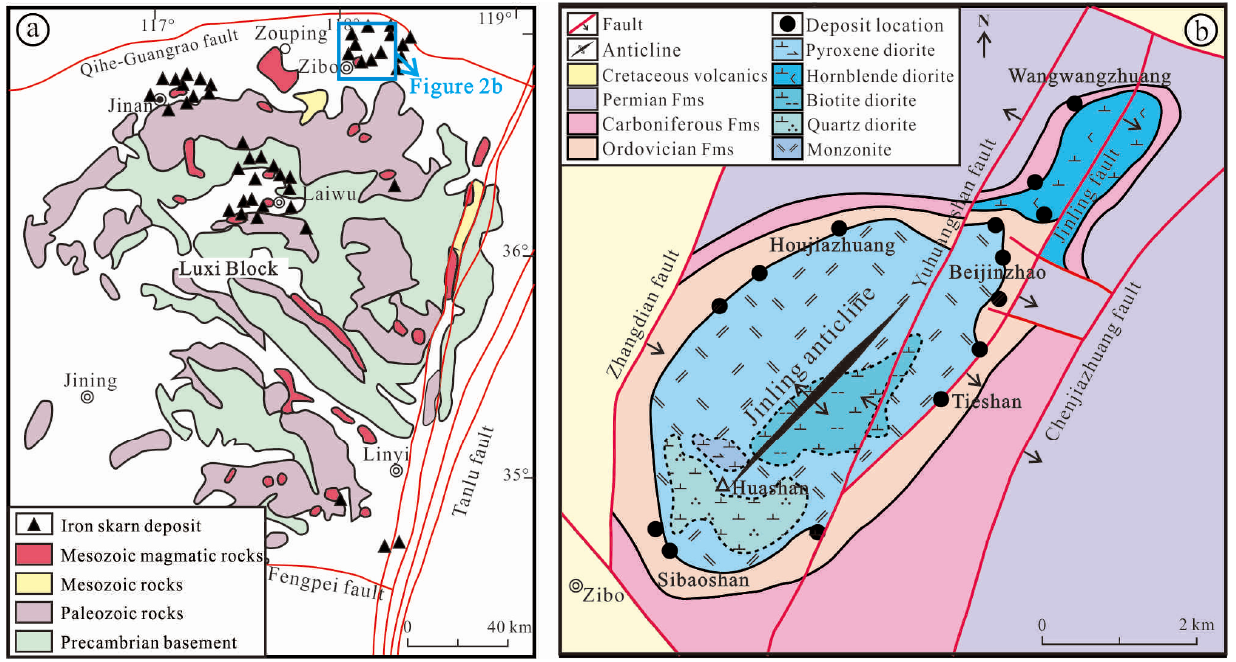
Figure 2. ( a ) Simplified geological map of western Shandong (modified from Lan et al. [22]). ( b ) Sketch map of the Jinling pluton and distribution of the Jinling iron skarn deposits (modified from Hao [23]).